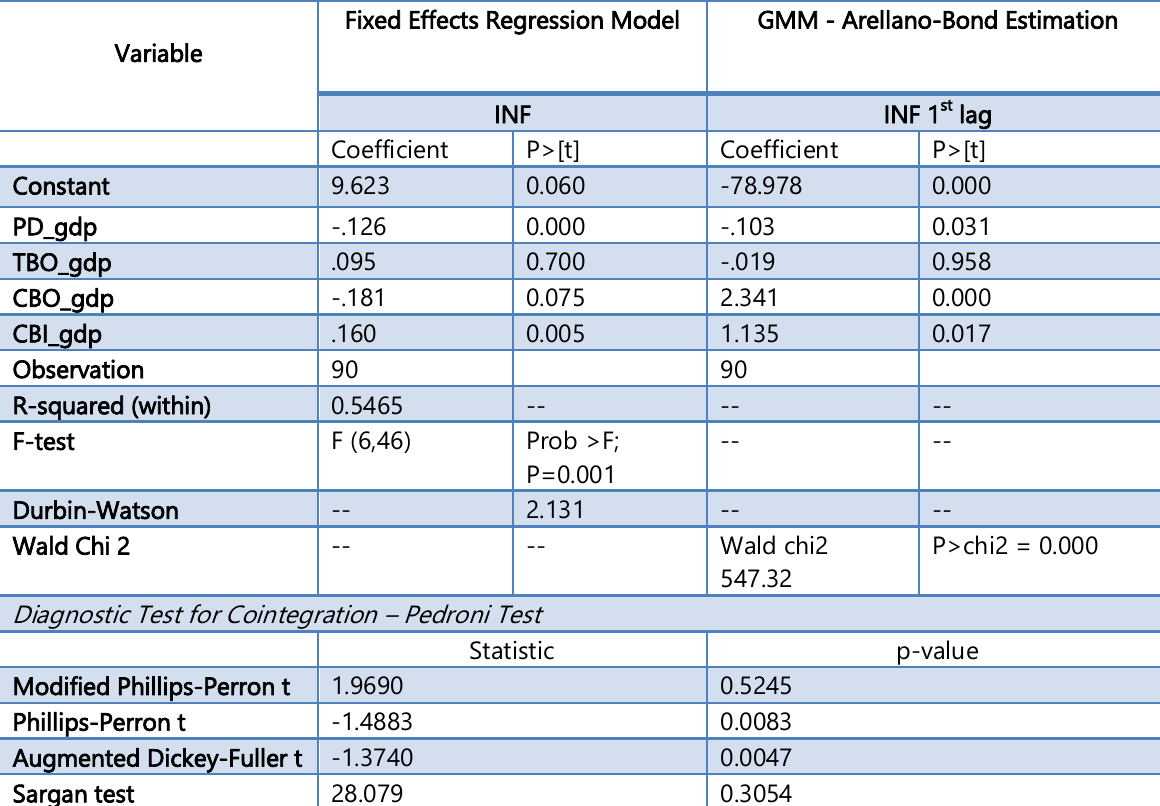
Table 4: Estimation Results (Source: Author’s